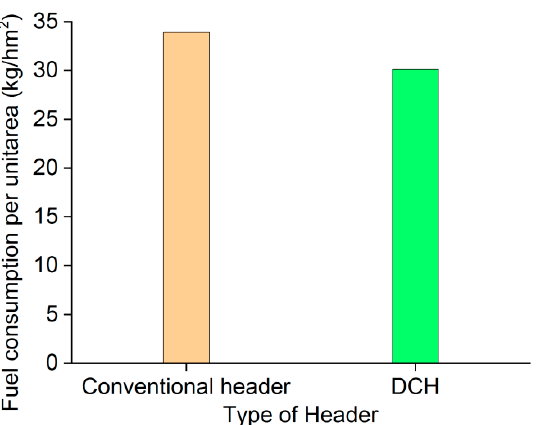
Figure 15. Fuel consumption per unit area of the WCH using different headers.